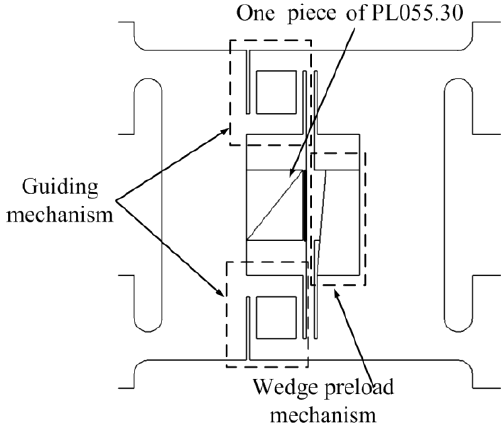
Figure 8. Details of pushing element.